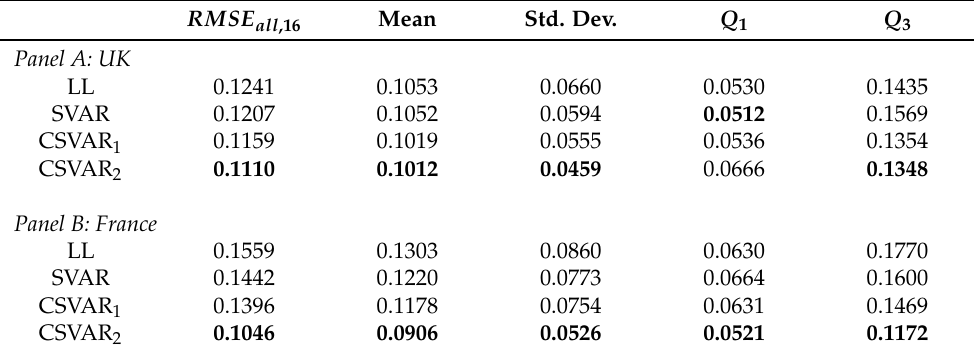
Table 3. Summary of two-population results. For each column, the smallest number is in bold. RMSE all ,16 Mean Std. Dev. Q 1 Q